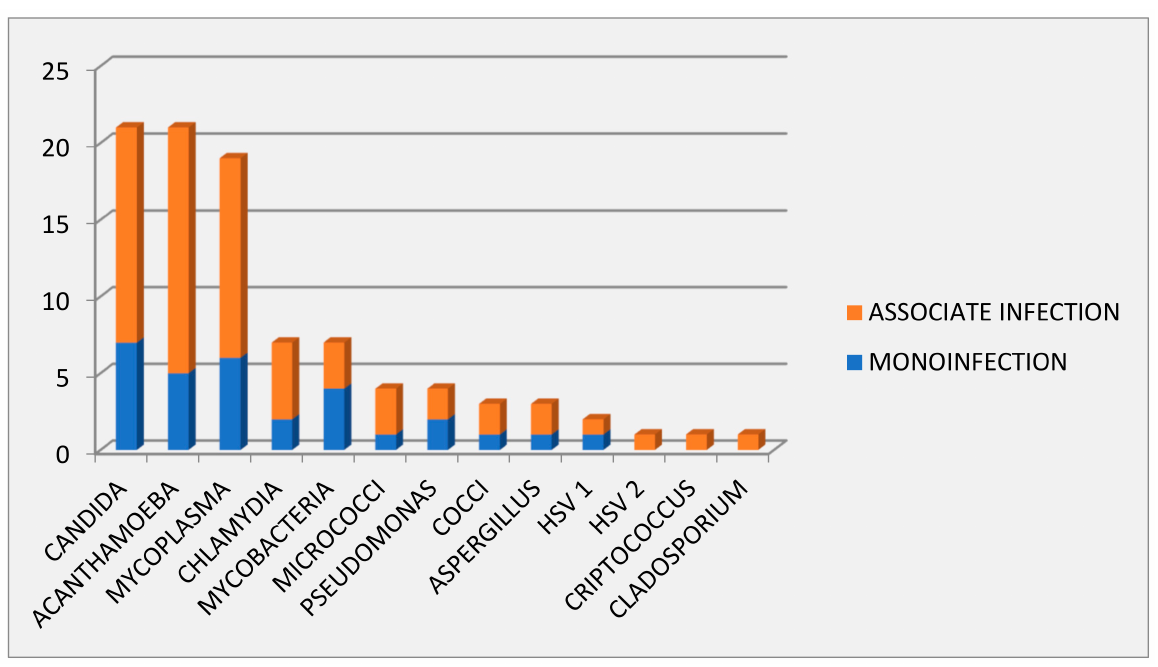
Figure 2. Evaluation by scanning electron microscopy: single organism infections and